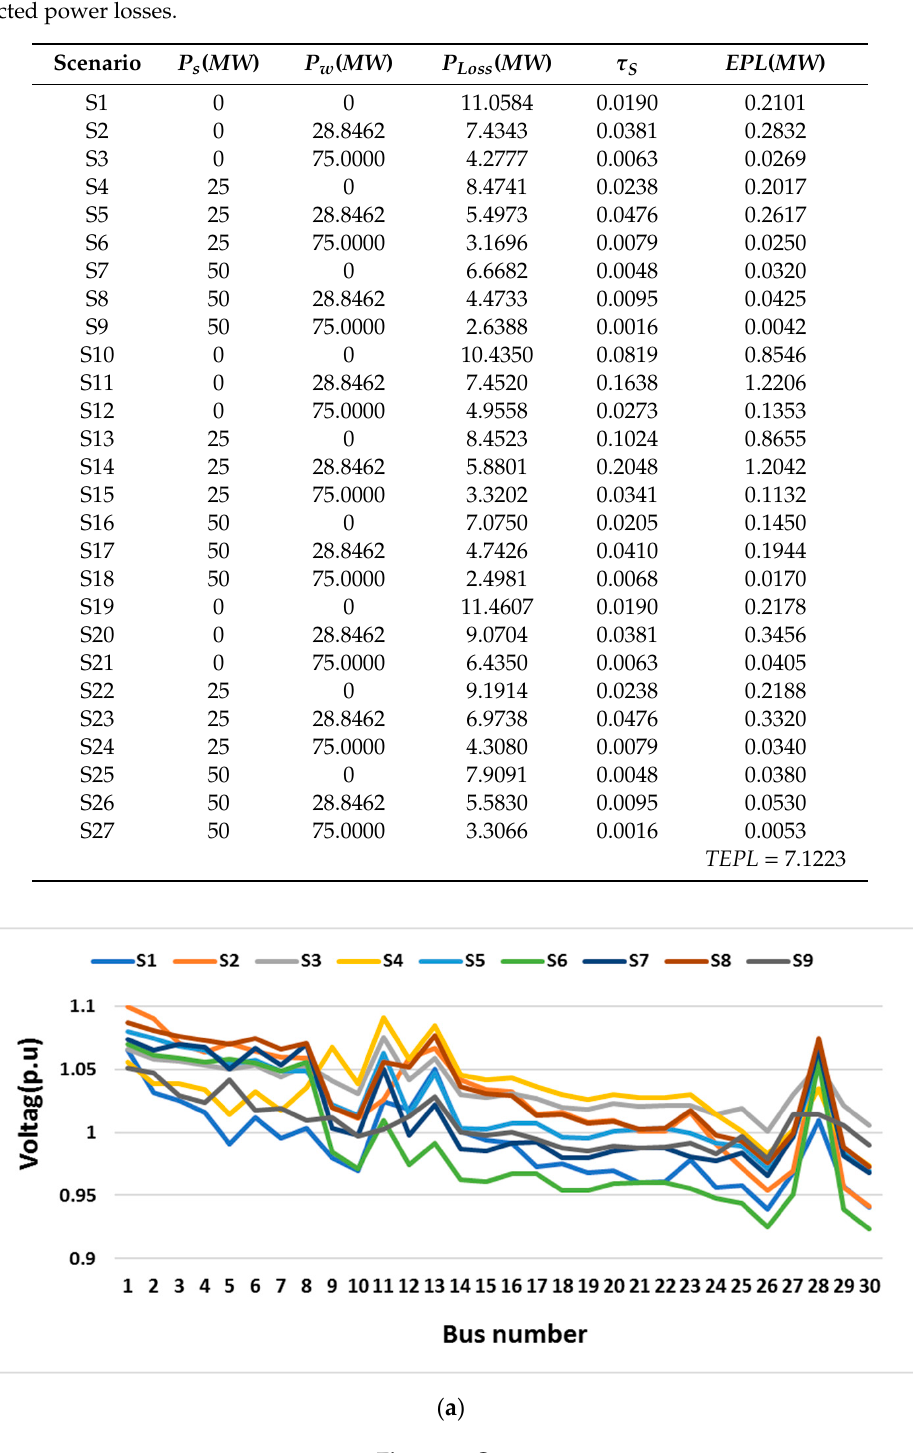
Table 6. Selected scenarios and the corresponding output powers of renewable systems and the expected power